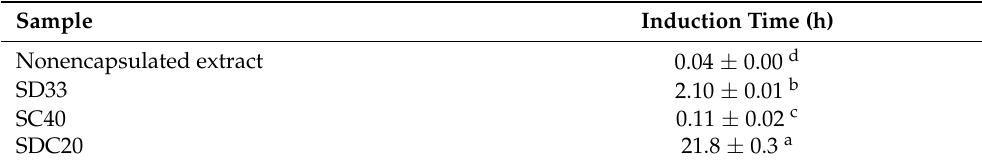
Table 5. Oxidation induction period of nonencapsulated and encapsulated carotenoid-rich extract, evaluated by Rancimat, at 120 ◦ C.